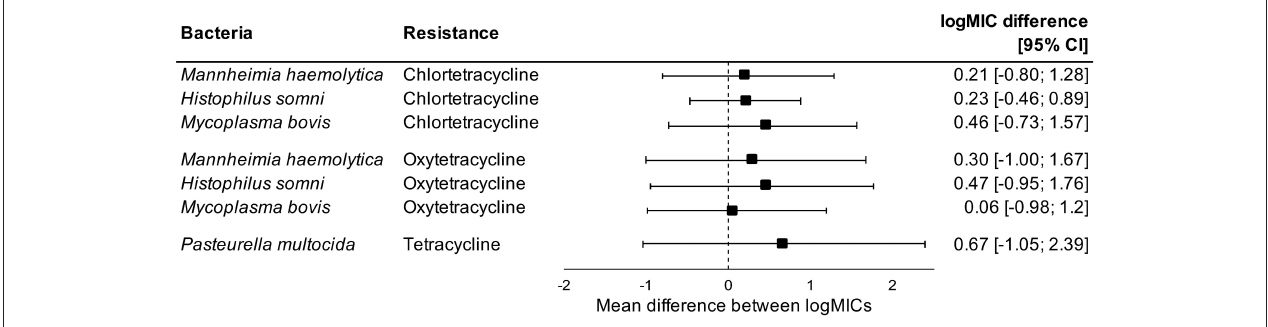
FIGURE 2 | Mean difference between antimicrobial-specific logMICs of bacteria isolated at REPROCESSING from the respiratory tract of calves fed, and not fed tetracyclines at feedlot induction. Model includes observations from all operations, including ones that administered tetracyclines parenterally at induction. Sensitivity analysis indicated no effects of removing observations from operations that administered tetracyclines parenterally at induction.